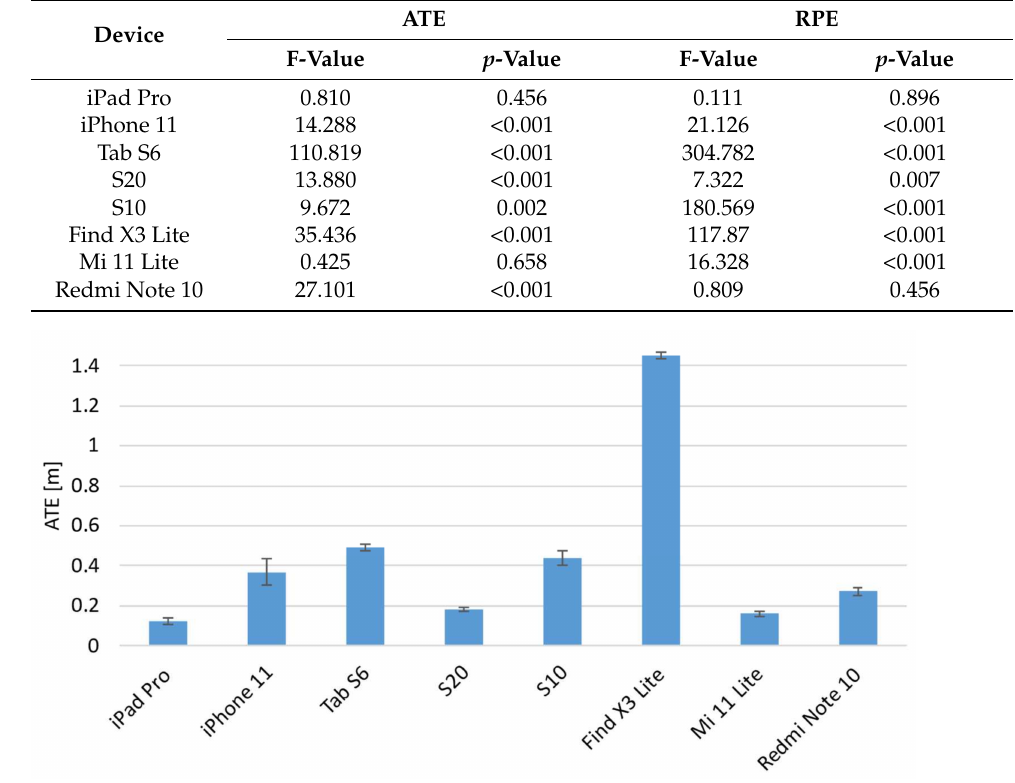
Figure 10. Absolute Trajectory Error (ATE) evaluation results related to the eight-shaped